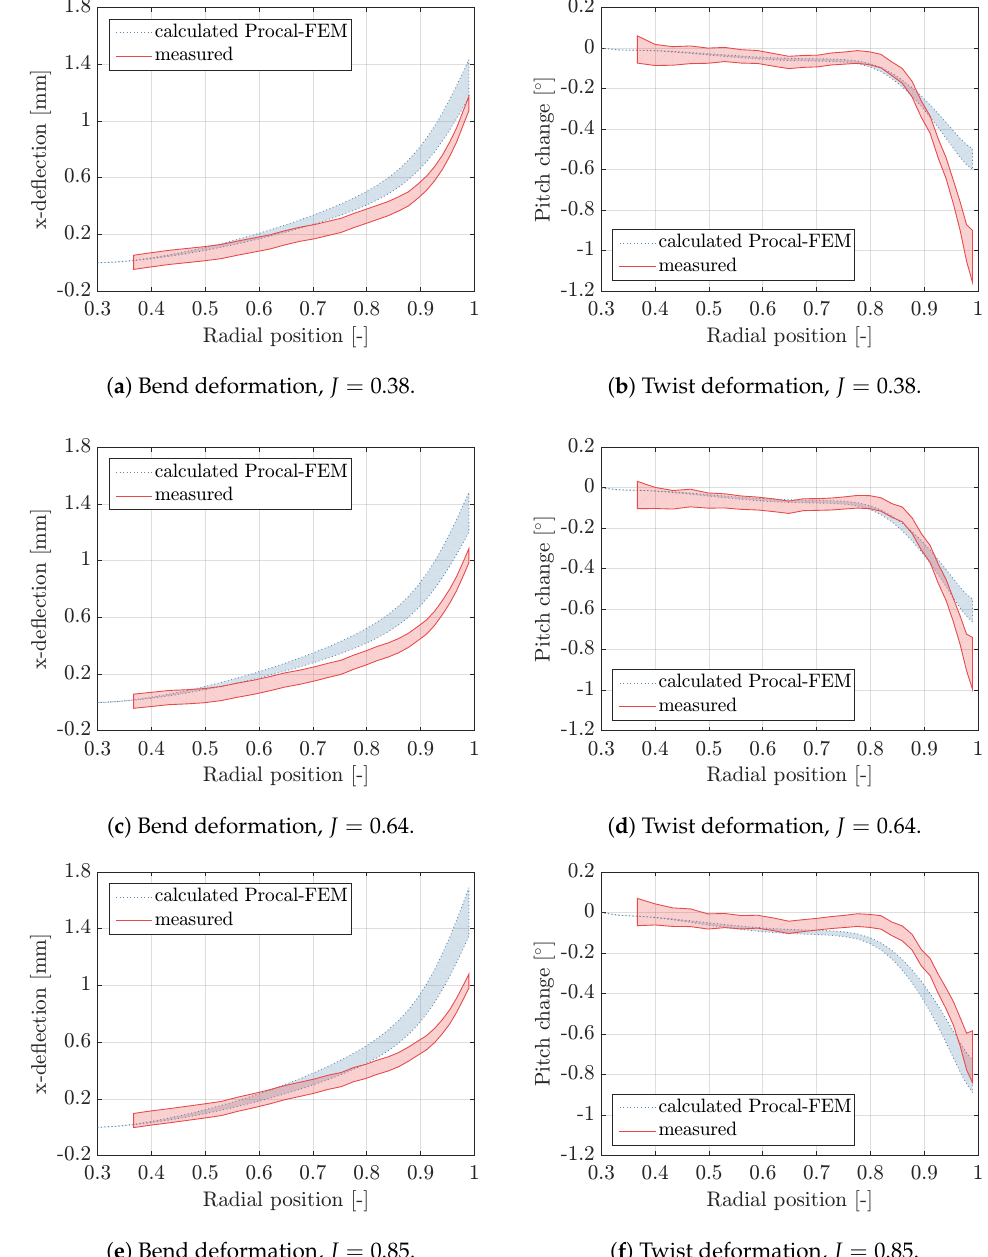
Figure 17. Uncertainty intervals for bend ( left ) and twist ( right ) deformations of mid-chord points of propeller 45 blade 1 against the radial position on the blade, for the measured and calculated